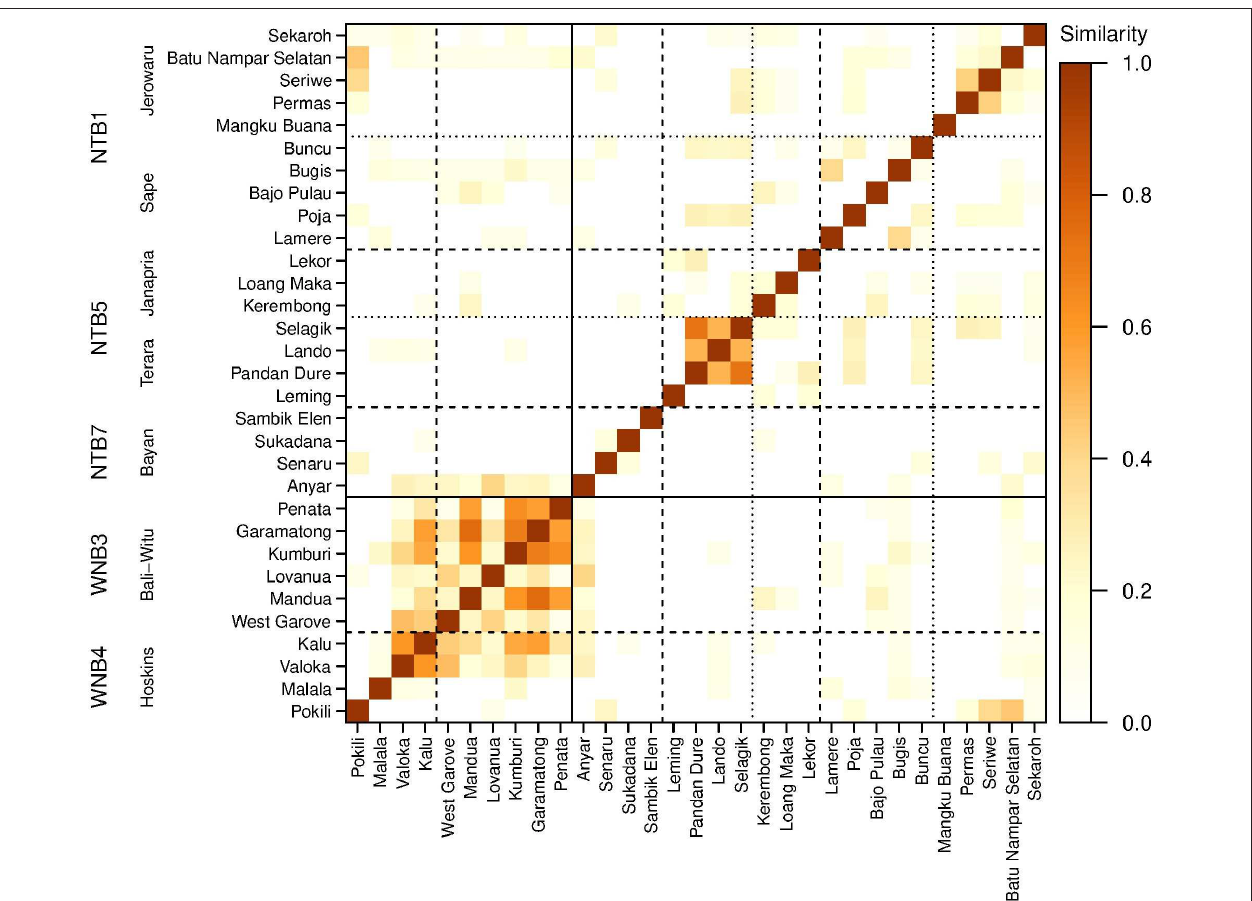
FIGURE 6 | Similarity matrix between villages’ adaptation strategies. Similarity is represented by the Steinhaus Similarity Index.